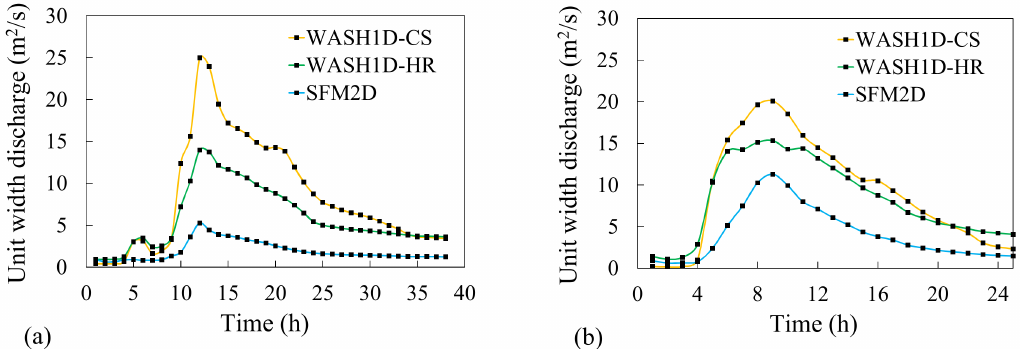
Figure 13. The simulated unit width discharges based on three approaches at Shuiwei water stage gauging station for ( a ) Typhoon Nesat and ( b ) Typhoon Maria.